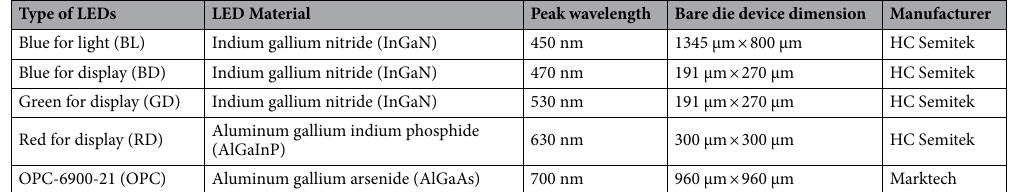
Table 3. Materials, peak wavelength, dimensions and manufacturers of the LEDs that are packaged.